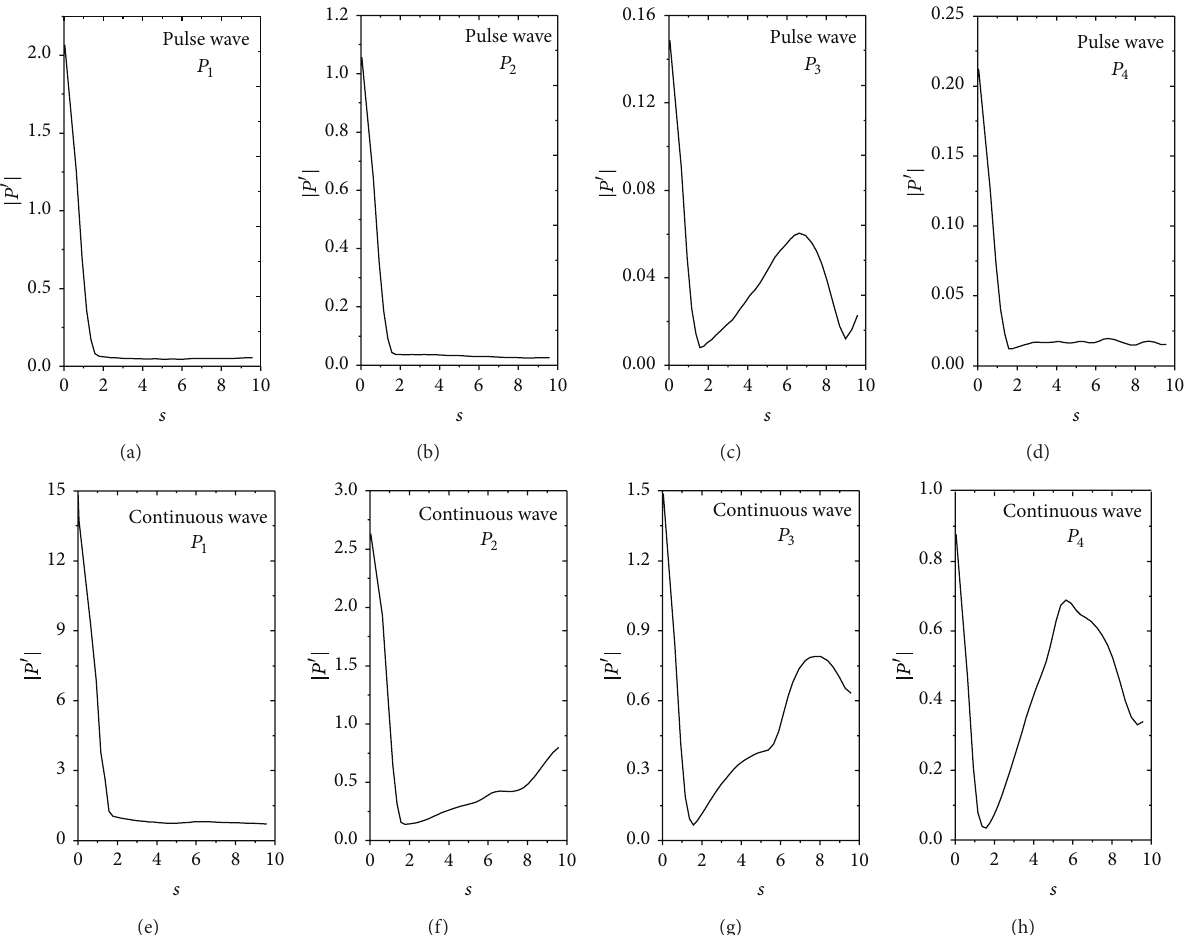
Figure 10: Comparison of pressure disturbances amplitudes in boundary layer for both pulse and continuous fast acoustic waves.